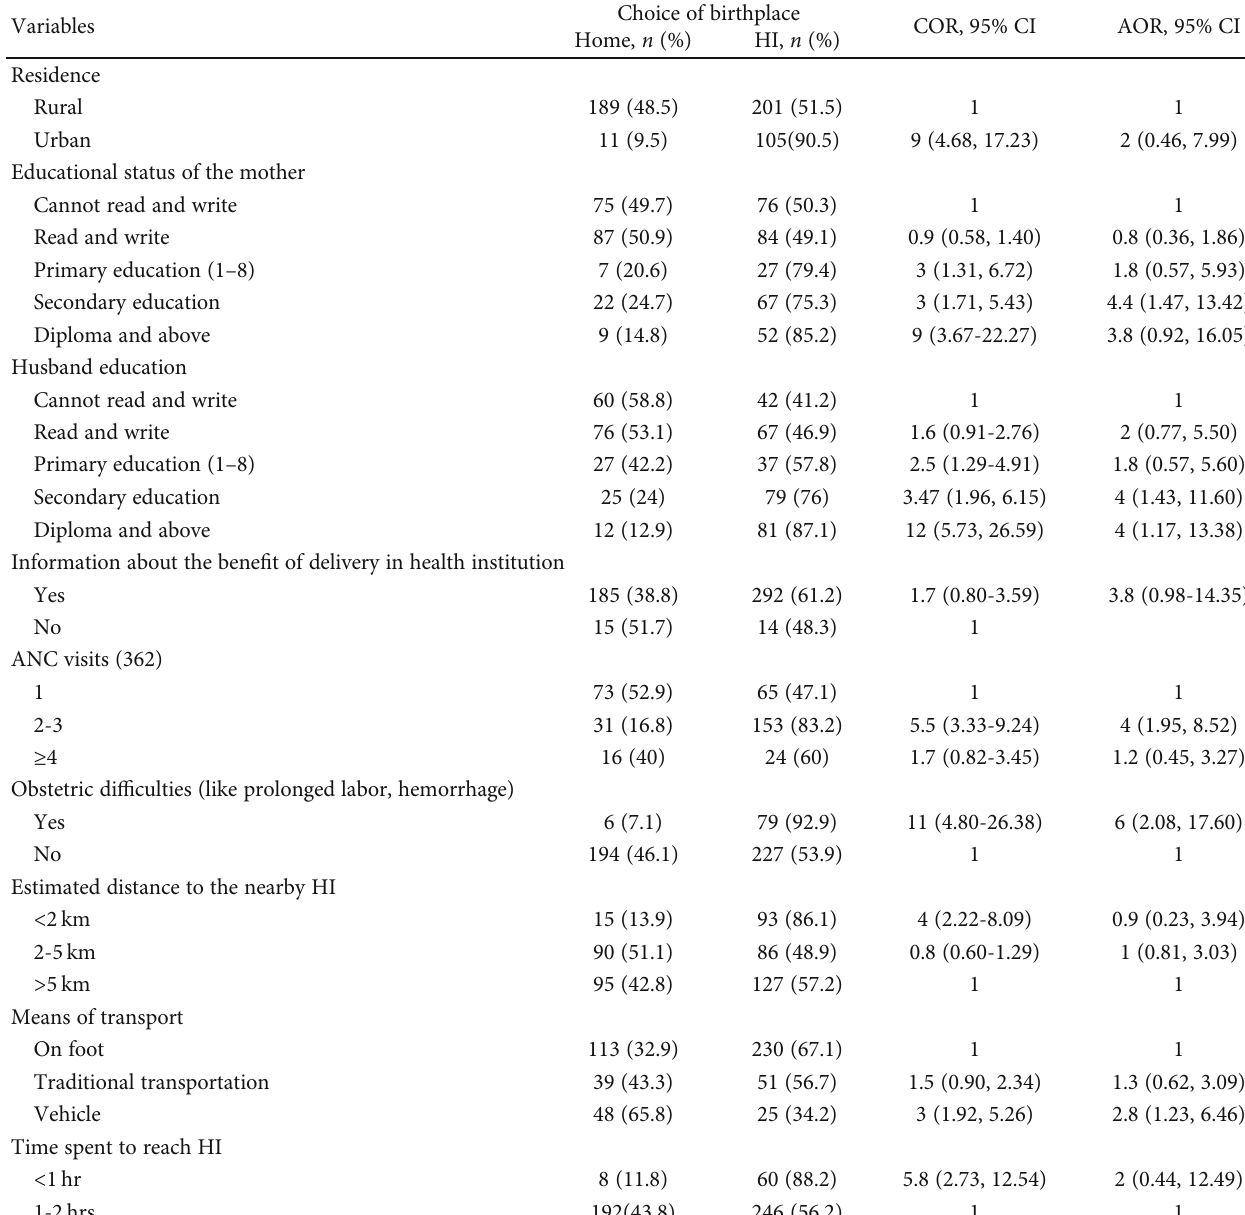
Table 4: Multivariate analysis of selected variables ( n = 506 ) with women ’ s choice of delivery place in Jimma Arjo District, East Wollega Zone, Oromia Regional State, Ethiopia, May